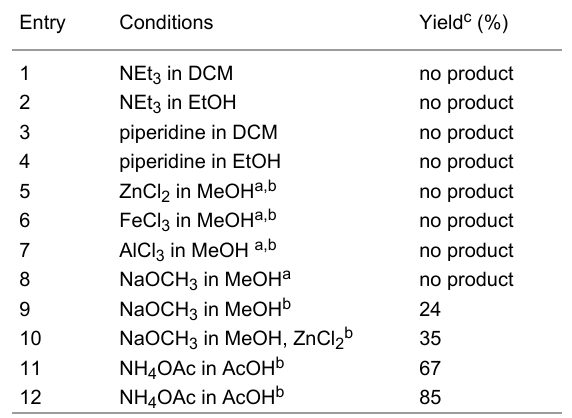
Table 1: Effect of base and solvent on the yield for the synthesis of 2a